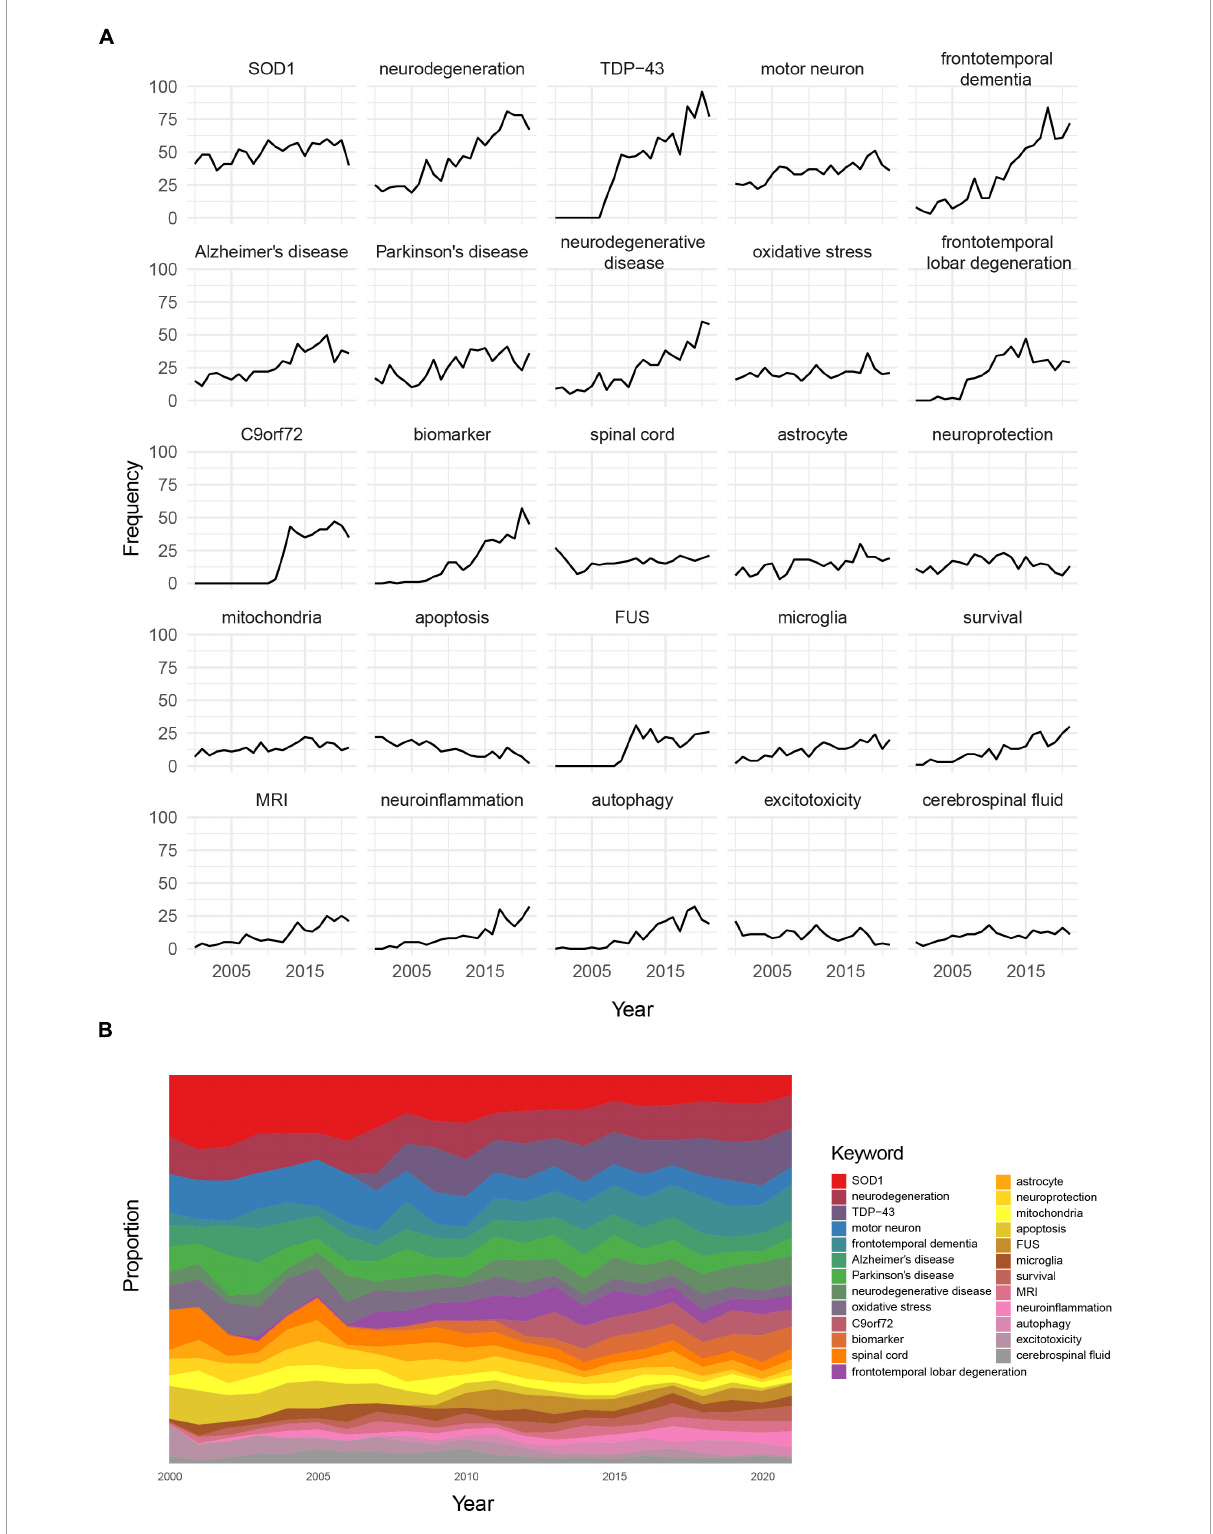
FIGURE4 (A) Frequency dynamics for the top 25 most used keywords. (B) Proportion trends for the top 25 most used keywords (the color of the strip represents different keywords, and the width of the strip represents their